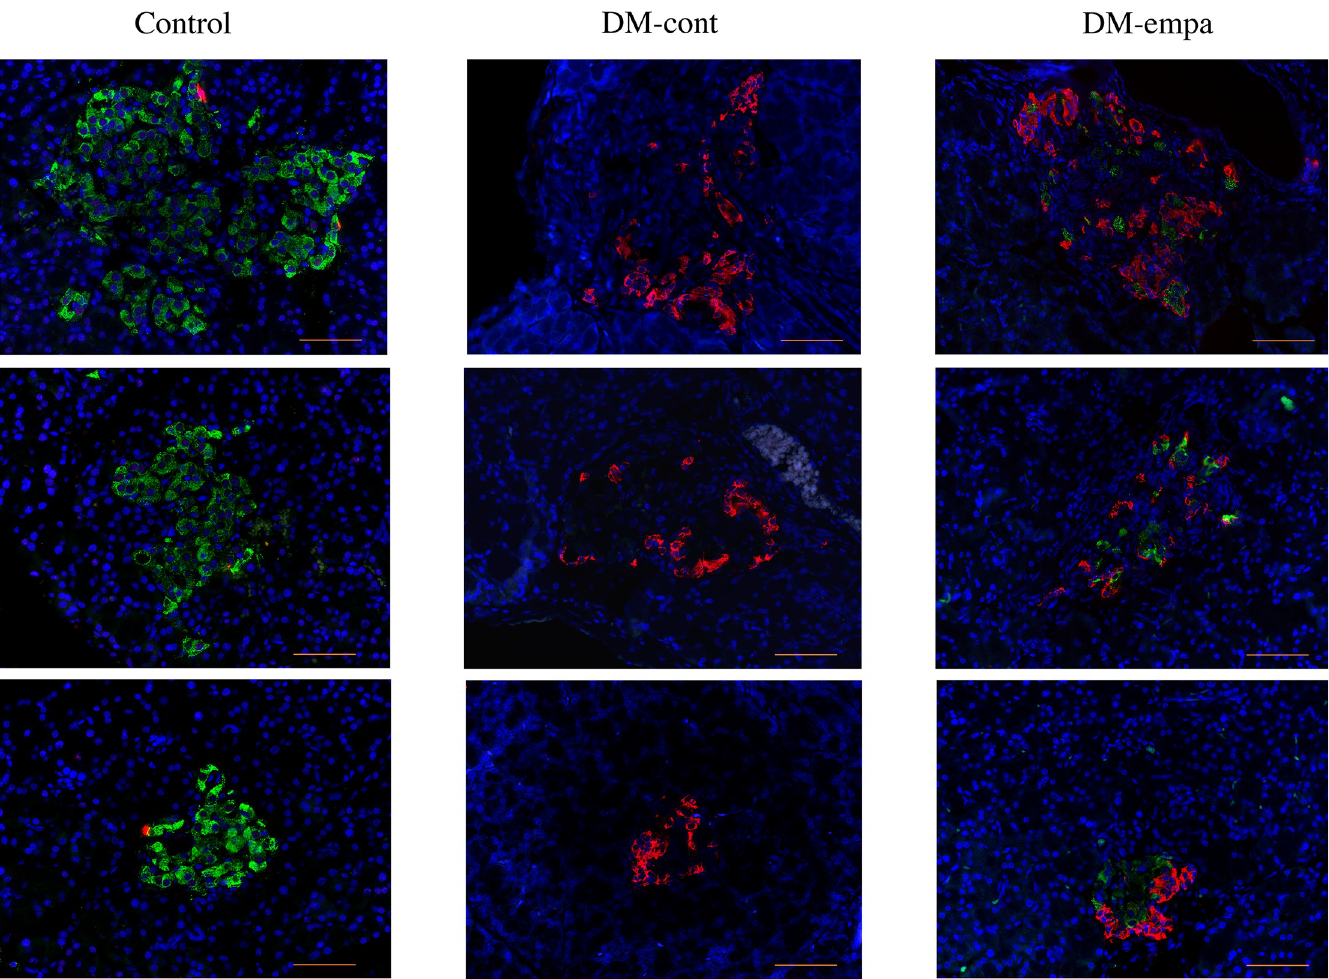
Fig 2. Assessment of insulin and glucagon producing cells after empagliflozin treatment. Immunologic detection of insulin (green) and glucagon (red) in pancreatic islets of rats in the control, DM-cont and DM-empa groups after 12 week treatment period. Scale bar: 50 μ m.